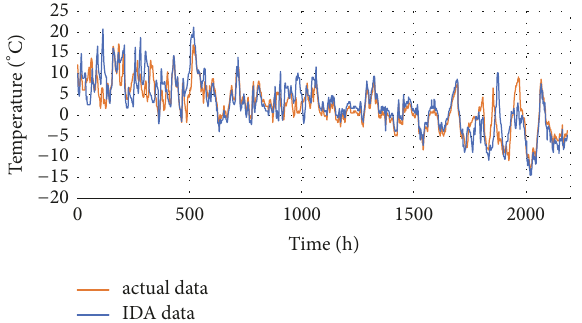
Figure 5: Difference between outdoor temperatures of IDA ICE and actual data.